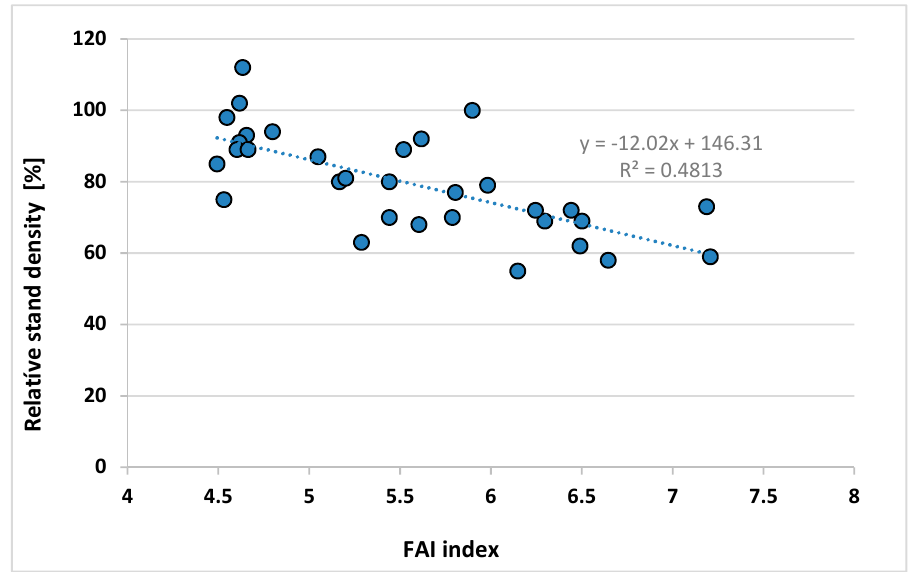
Figure 10. Regression of relative stand density of sessile oak stands vs. the FAI values of the selected locations (I. Berki, original).